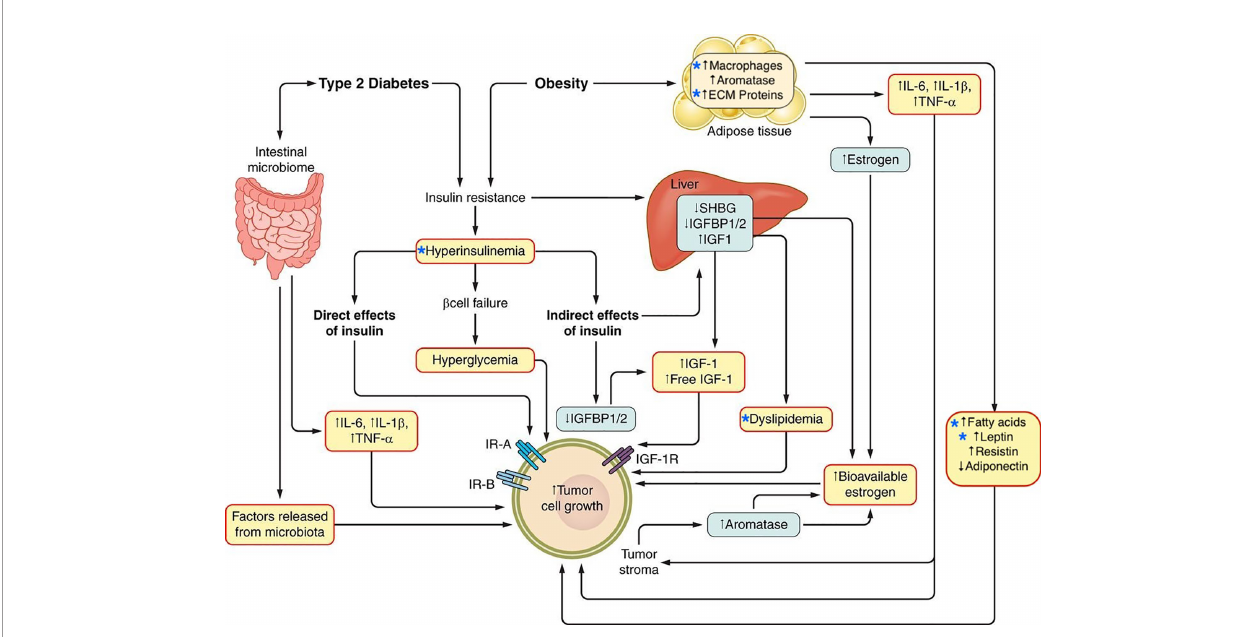
FIGURE 1 | Potential mechanisms linking obesity and type 2 diabetes and cancer. The relationship between type 2 diabetes, obesity, and cancer is potentially mediated by multiple mechanisms, including metabolic conditions such as hyperinsulinemia and dyslipidemia as well as the alteration of adipose tissue which is characterized by in fl ammation and a tumor growth-promoting secretory pro fi le. Stars indicate factors discussed in this review. Adapted from: Gallagher, E.J., and LeRoith, D (2015). Obesity and Diabetes: The Increased Risk of Cancer and Cancer-Related Mortality. Physiol. Rev. 95 , 727 –